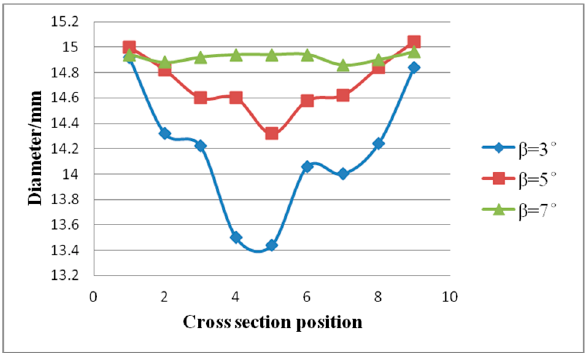
Figure 5. Diameters at the measured positions ( α = 25 ◦